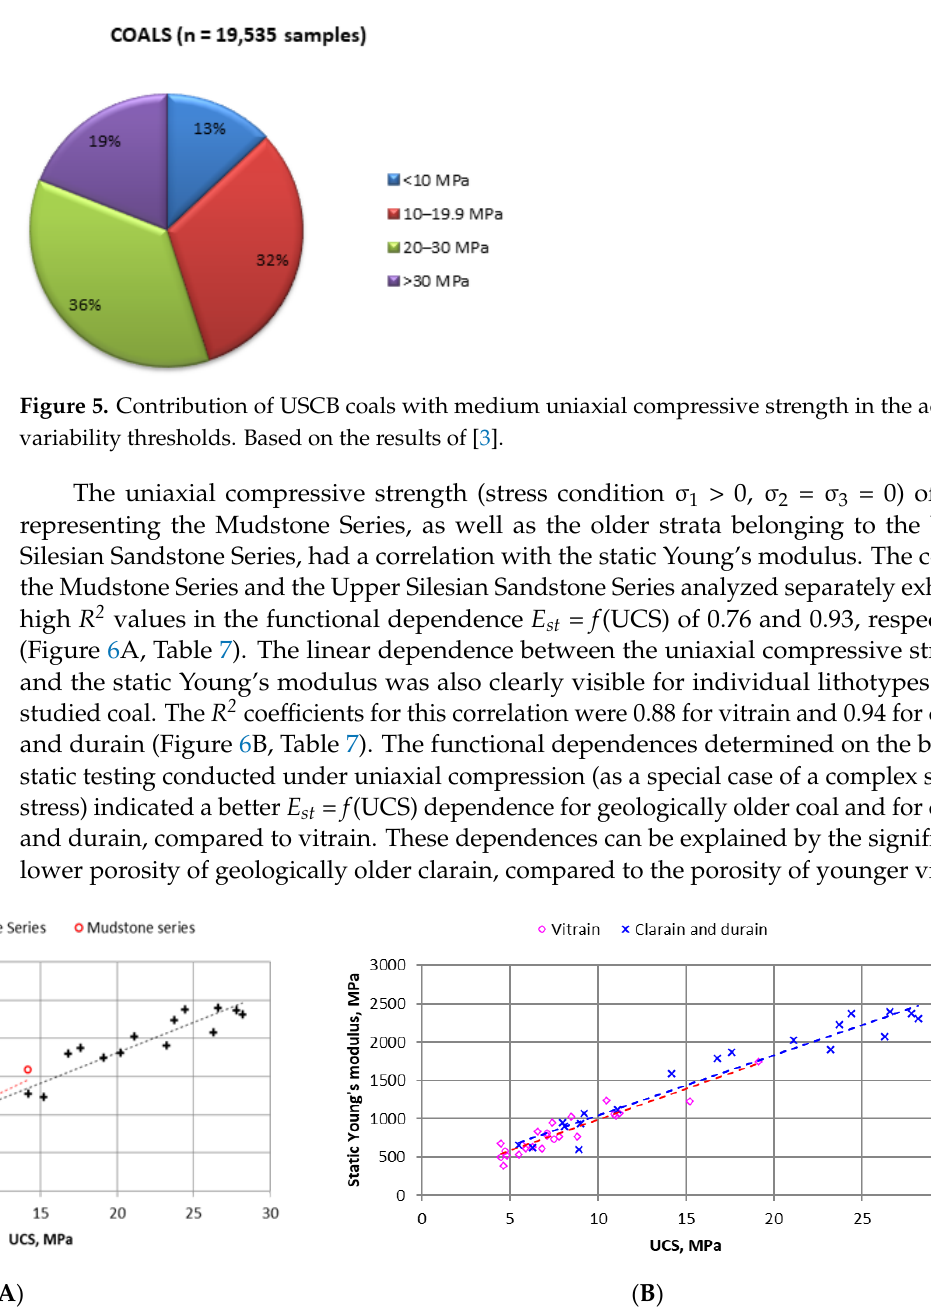
Table 7. Linear regression analysis results of E st = f (UCS) for coals of various geologic age and pet-